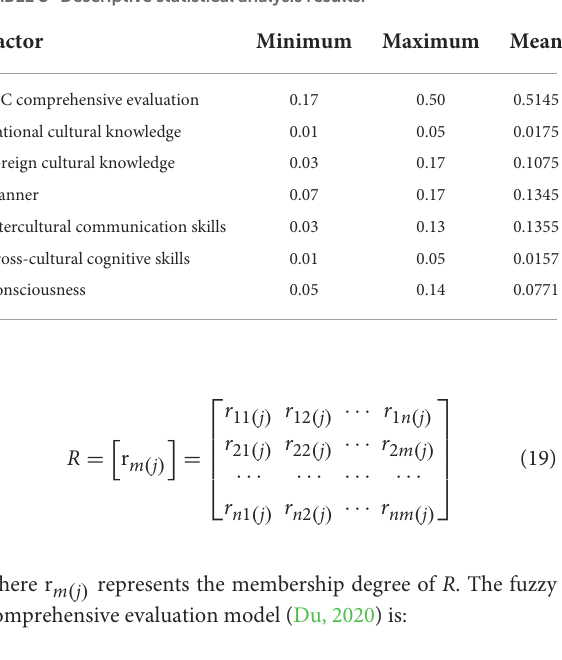
TABLE 3 Descriptive statistical analysis